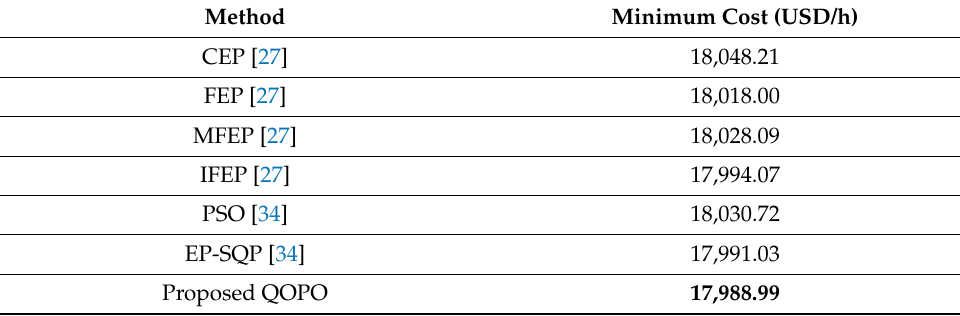
Table 4. Comparison of results of 13-unit system for the load demand of 1800